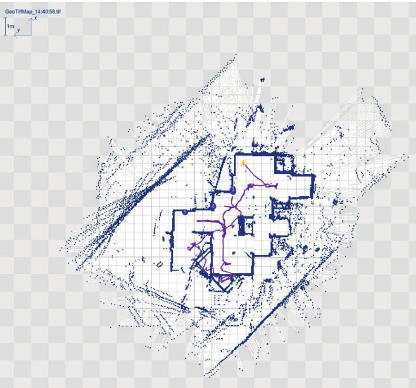
Figure 18: Mapping result of Hector-SLAM (China Robot Competition). Because the level keeping platform of the radar is not sensitive enough, and it cannot be adjusted and keep the platform in time when the robot crosses obstacles, the radar may scan the walls outside the field. Hector cannot judge and filter, so it is recorded on the map.